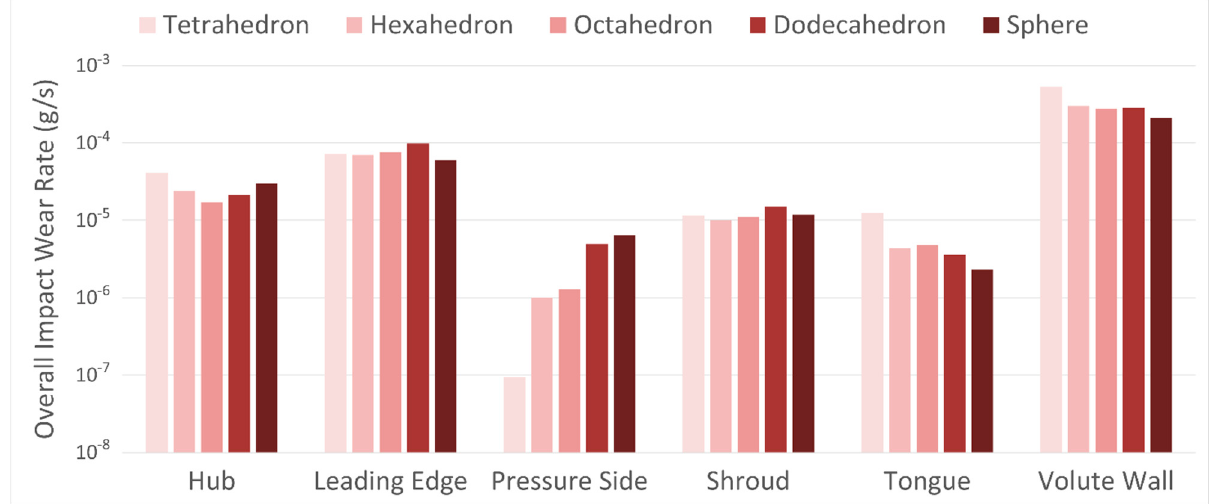
Figure 10. Overall impact wear rate of flow parts.